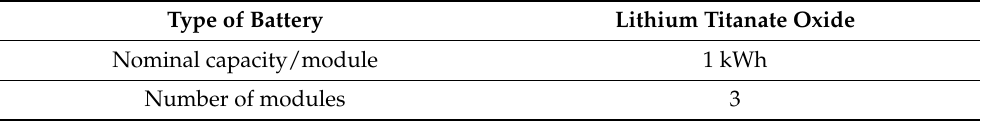
Table A4. ELECTRICITY